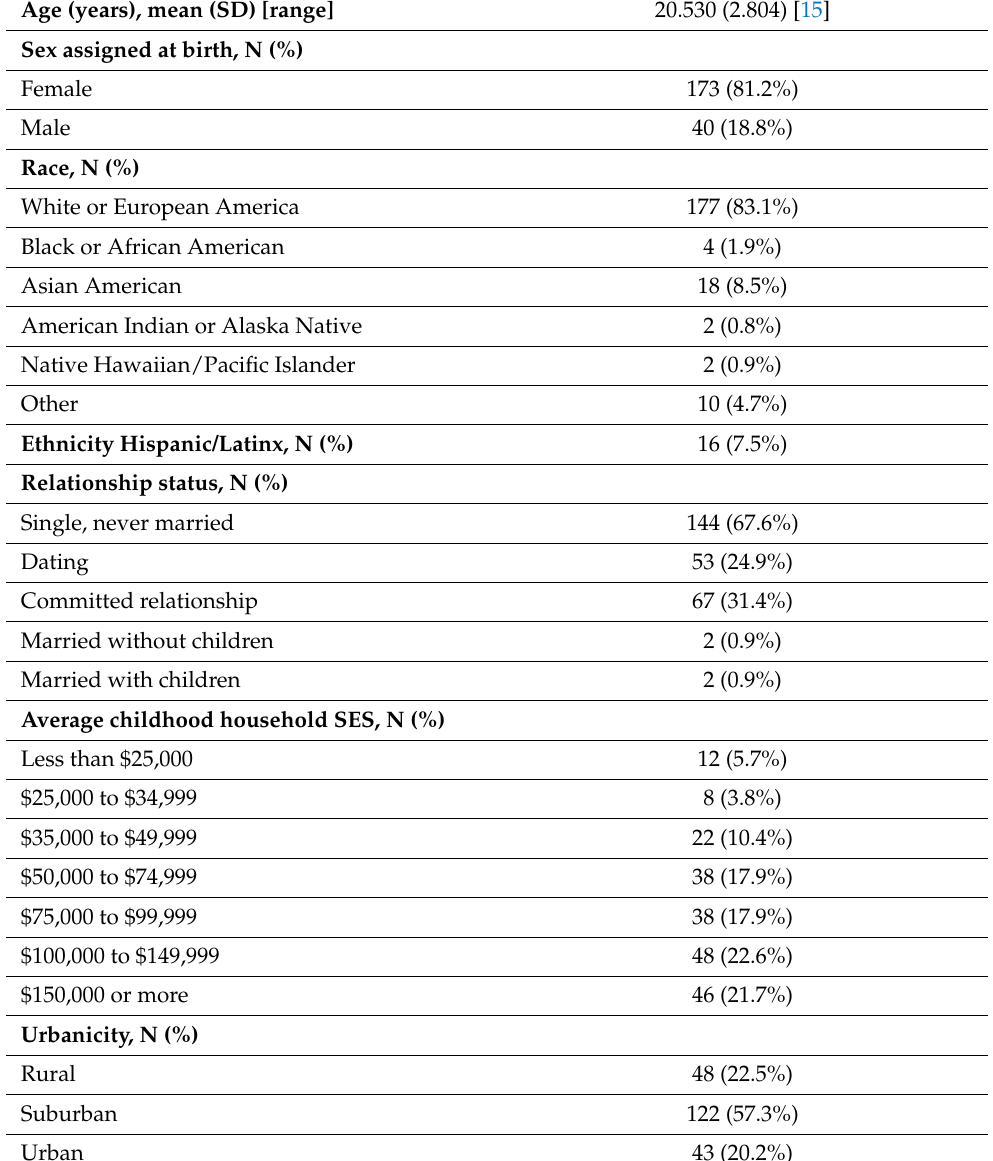
Table 1. Sample demographics (N =